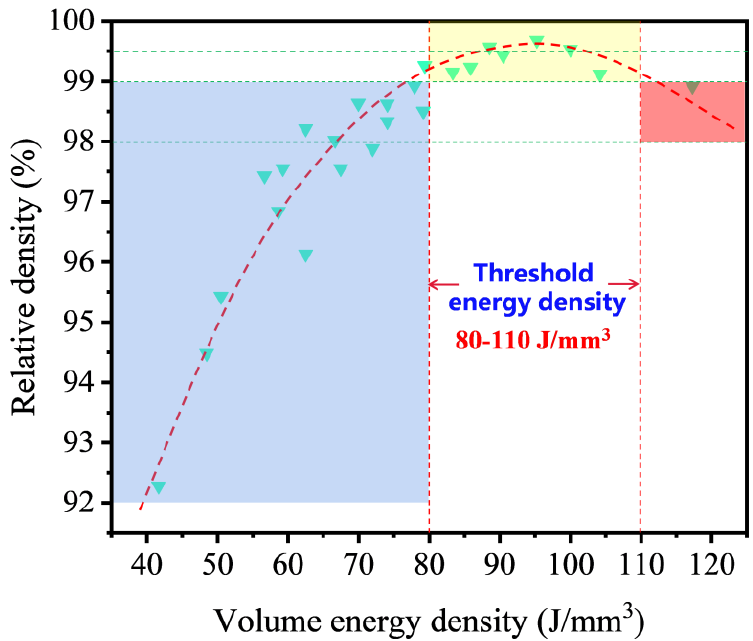
Figure 3. Relationship between relative density and volume energy density for SLM-fabricated Inconel 718 alloy. The points are the results of Table 3.